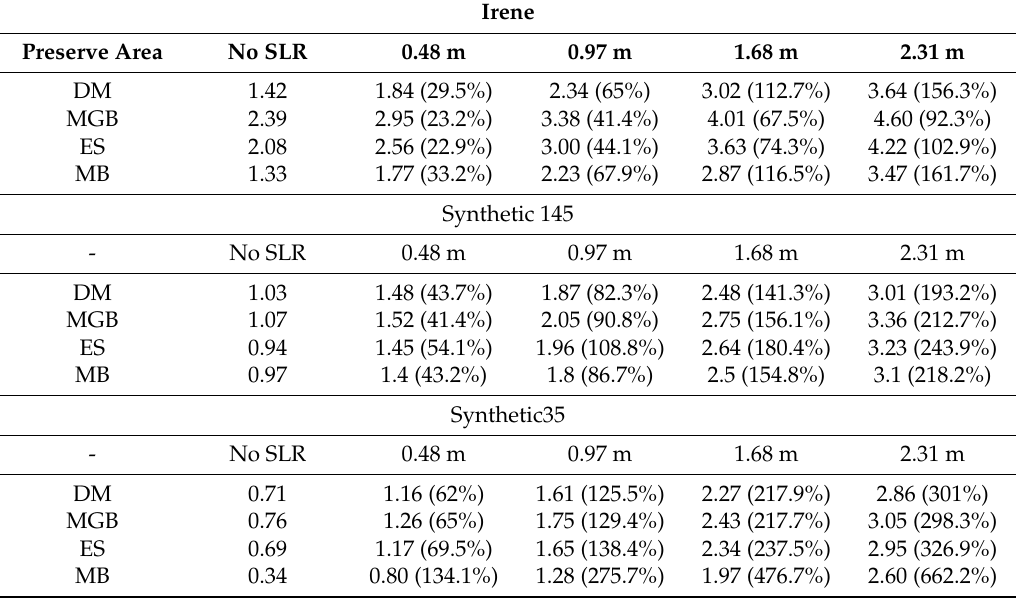
Table A3. Modeled Data showing the maximum water levels for each Preserve Area. The percent increase in water level is shown in parenthesis.